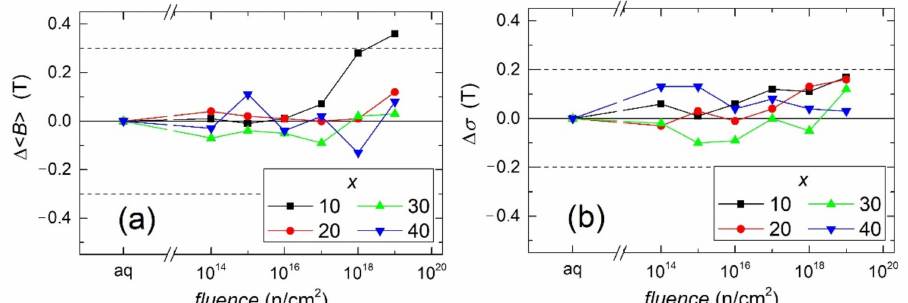
Figure 10. Differences of parameters of distributions of hyperfine magnetic fields, P ( B ), obtained from Mössbauer spectra of the Fe 80- x Ni x B 20 amorphous metallic alloy, plotted against neutron fluence for the indicated Ni contents: ( a ) Average hyperfine magnetic field, ∆ (cid:104) B (cid:105) ; ( b ) standard deviation, ∆ σ . Solid lines are only guides to an eye, dashed lines represent the error